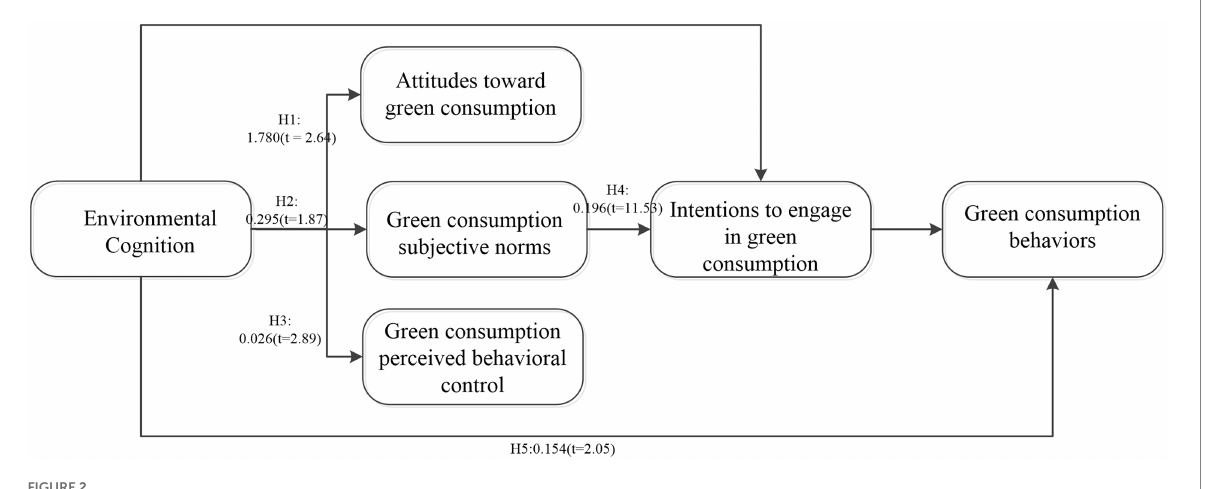
FIGURE 2 TPB model of green consumption behavior with